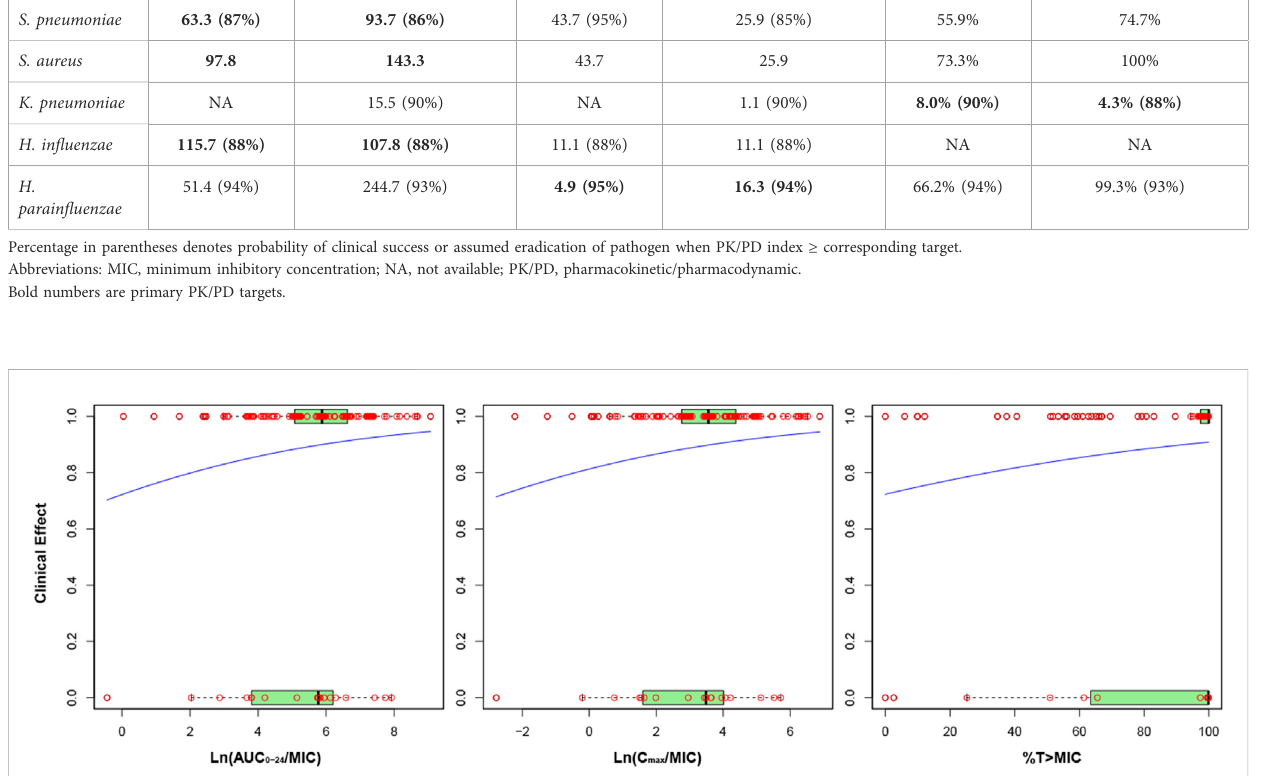
the AUC 0-12 and C max increased by 2.73 times and 1.71 times respectively in case of reduced CL cr (20 ml/min) compared to the control (CL cr = 75 ml/min) (Tanigawara et al., 2013). Similarly, the AUC 0-24 of levo fl oxacin increased by 62.4% and 152.5% when CL cr corresponding values in subjects with normal renal function (CL cr = 120 ml/min) (Zhang et al., 2009). The corresponding C max increased by 56.7% and 22.3%, respectively. The authors